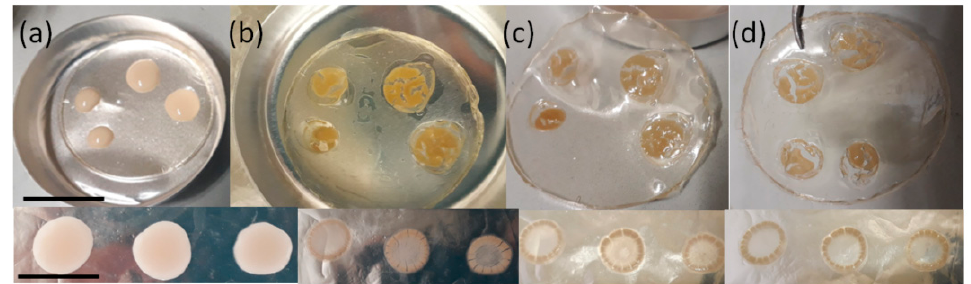
Figure 6. ( Top ) Yeast cell biofilm formation on PMMA/GO film at different times: ( a ) as deposited, ( b ) 10 s, ( c ) 50 s, and ( d ) 100 s. The scale bar indicates 2 cm. ( Bottom ) Yeast cell biofilm formation on PMMA film at different times: ( a ) as deposited, ( b ) 10 s, ( c ) 50 s, and ( d ) 100 s. The scale bar indicates 0.5 cm.